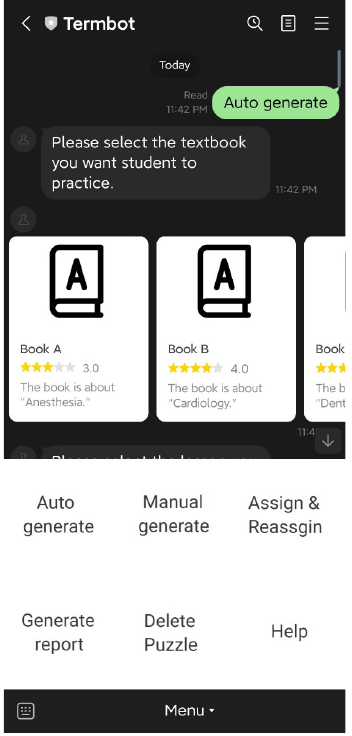
Figure 7. The function “Auto generate”.